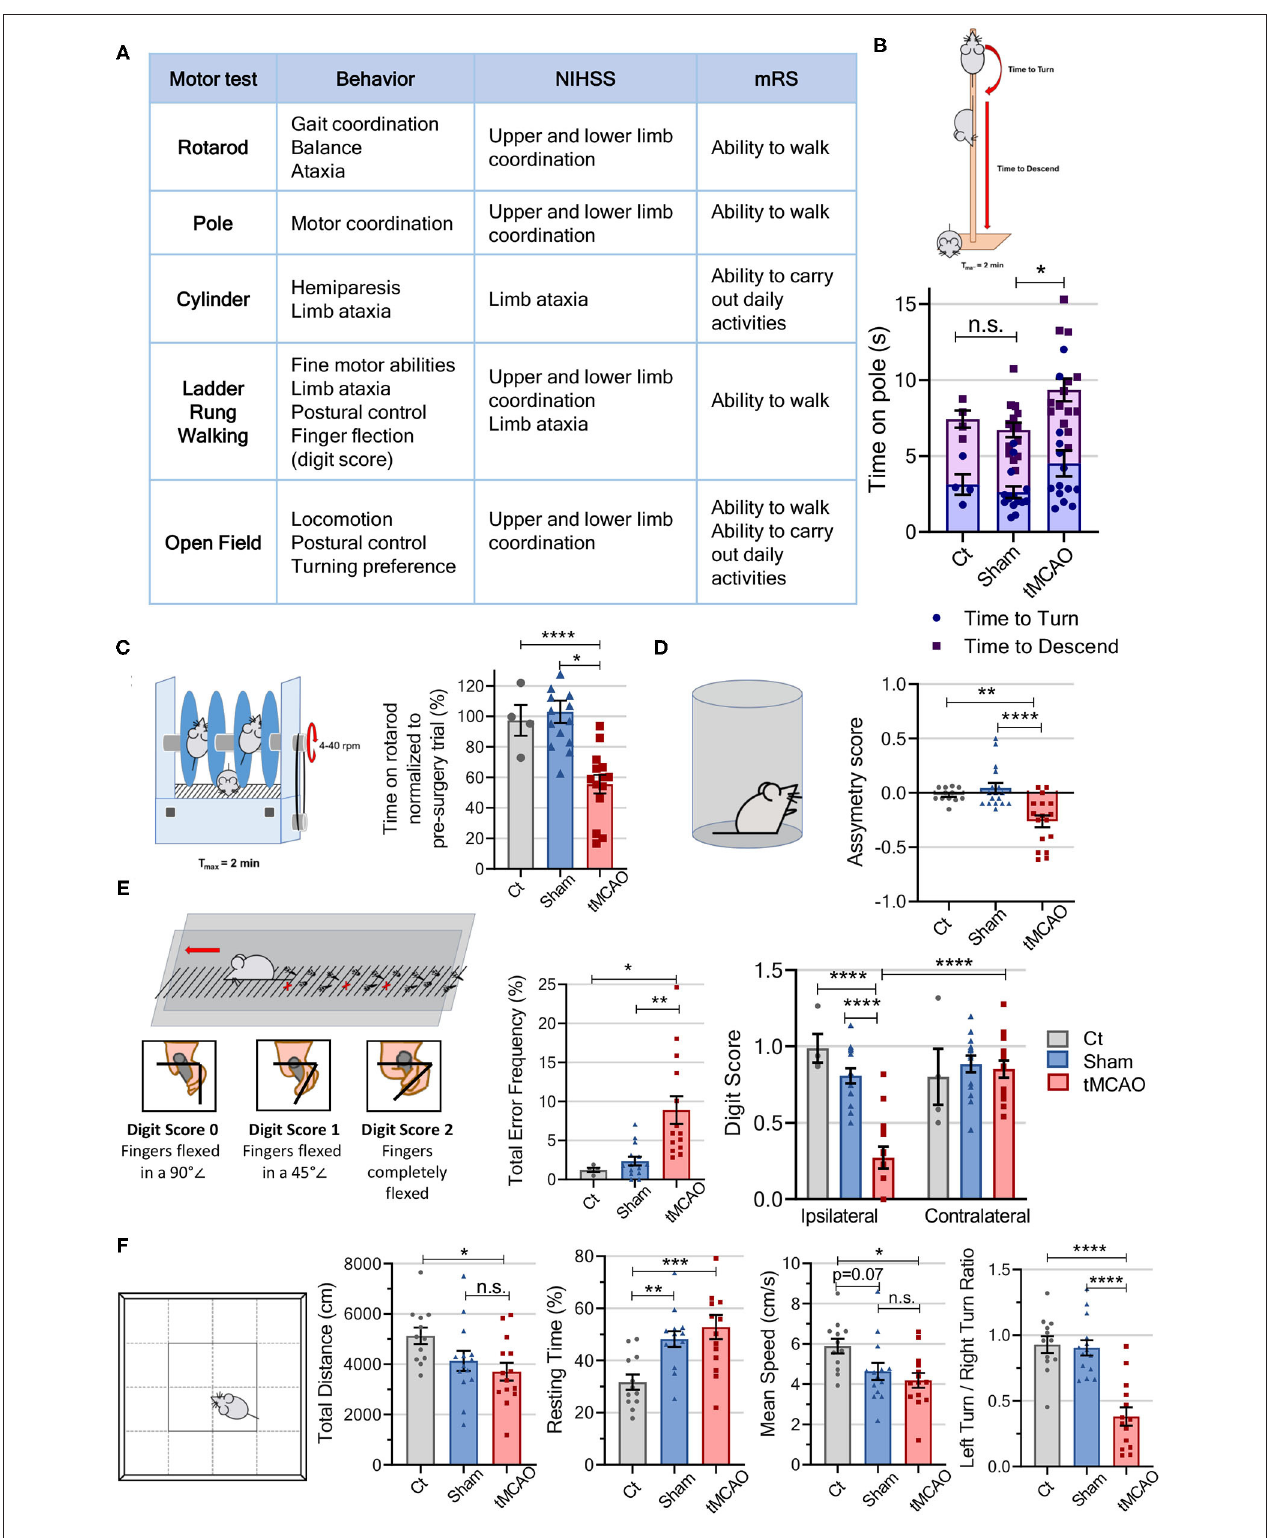
FIGURE 3 | Motor tests of the behavior workflow allow for differentiation of tMCAO from sham and Control animals in different locomotor tasks. (A) Table comparing the parameters evaluated in the motor tests to the scores assessed in both the mRS and the NIHSS. (B) Schematic representation of the pole test. Time, in seconds, the mice took to both turn and descend a vertical pole presented in the graph [CT n = 4 (4 females), sham n = 14 (5 males and 9 females), tMCAO n = 14 (9 males